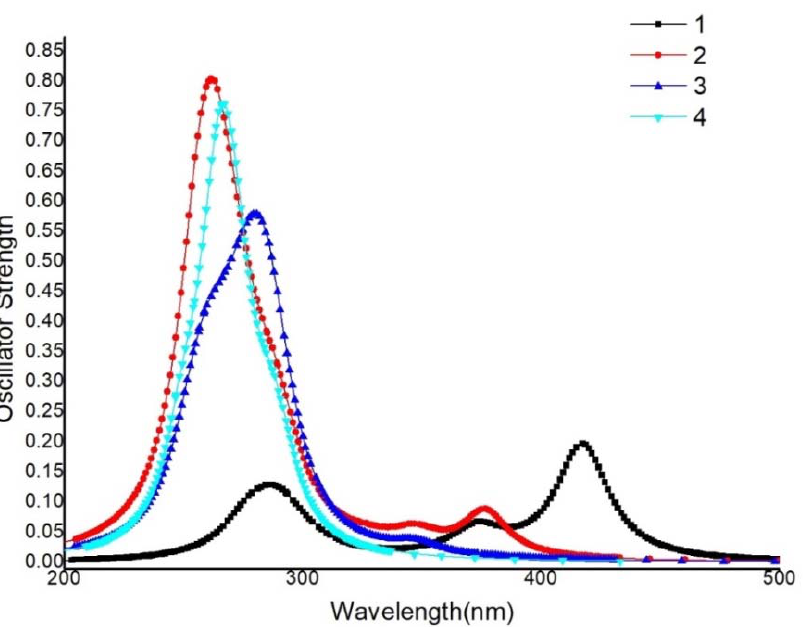
Figure 4. Simulated absorption spectrum of these complexes in PCM solution (CH 2 Cl 2